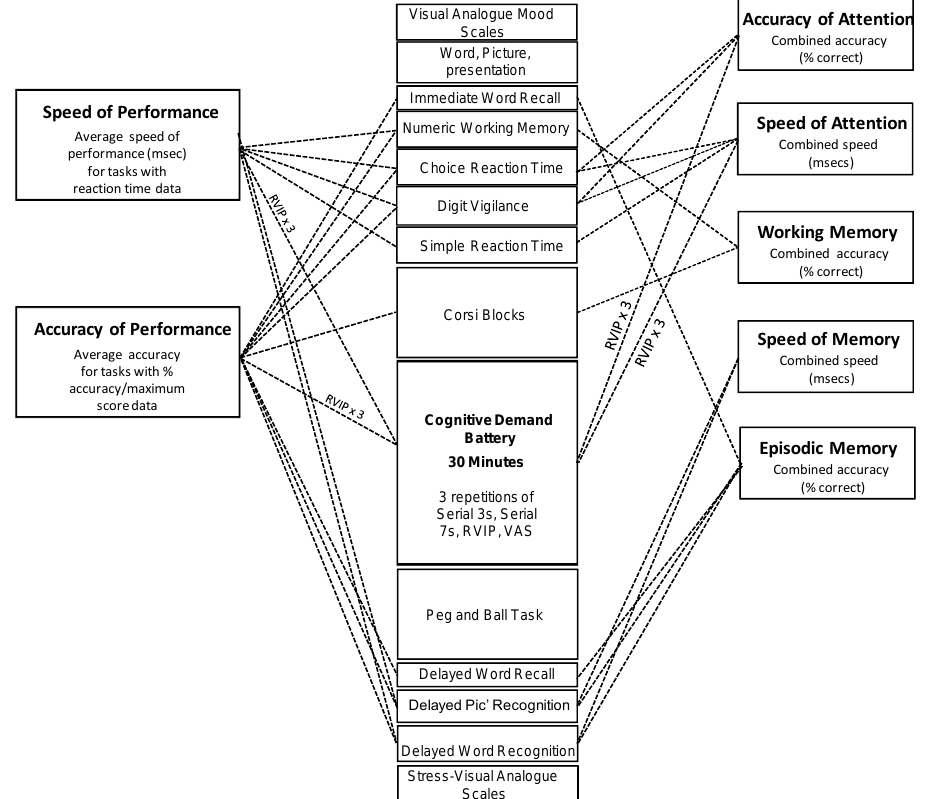
Figure 2. Cognitive assessments. The running order of tasks and their contribution to the cognitive factors (to the right) and global performance measures (to the left) derived from the overall battery. The same assessment was completed at the pre-treatment baseline and at 30 min, 3 h and 5 h